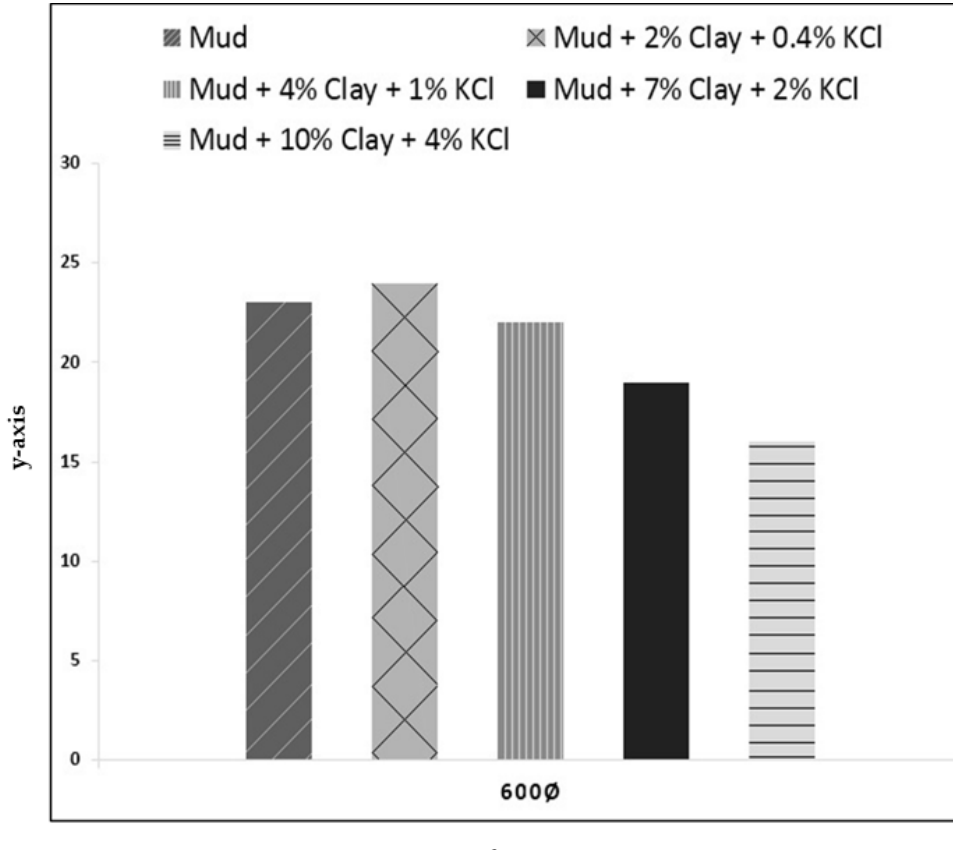
Figure 7. Trend correlation between default mud and KCL-concentrated mud + clay. The decrease in the rheological values from the clay-concentrated mud to the KCl- concentrated clay + mud are illustrated in Figure 7; the values were 25% (from 32 to 24 cP) for 0.4% KCl, 33.3% (from 33 to 22 cP) for 1% KCl, 48.6% (from 37 to 19 cP) for 2% KCl, and 65.2% (from 46 to 16 cP) for 4% KCl. We can also interpret the findings from the dial